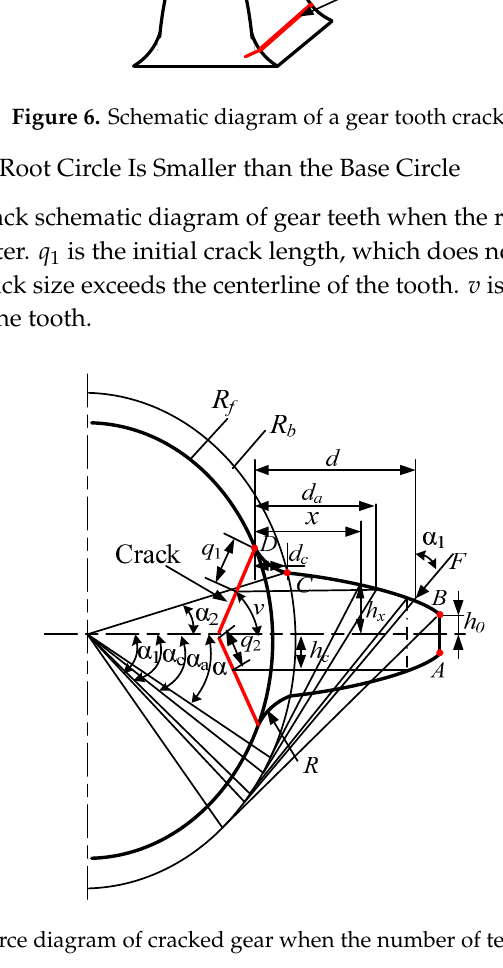
Figure 7. The force diagram of cracked gear when the number of teeth is less than 42.